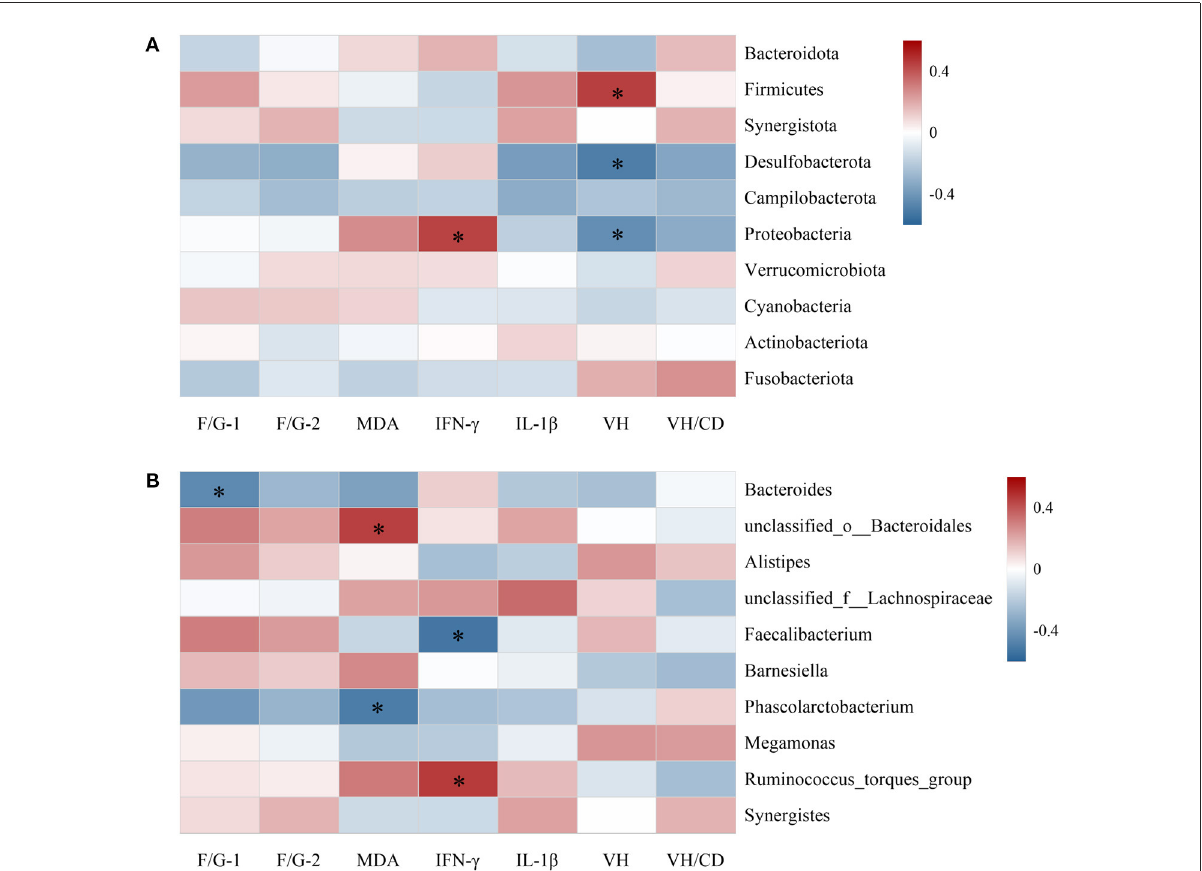
FIGURE3 Spearman’s correlation analysis of the top 10 abundant cecal microbiota at phylum (A) and genus (B) levels with growth performance and intestinal health of broilers. Red squares indicate positive correlation, blue squares indicate negative correlation, and significant correlations are marked by * ( P < 0.05); F/G-1, feed to gain ratio of 22–42 days of age; F/G-2, feed to gain ratio of 1–42 days of age; MDA, IFN- γ and IL-1 β , contents of malondialdehyde, interferon- γ and interleukin-1 β in jejunal mucosa; VH and VH/CD, villus height and villus height to crypt depth